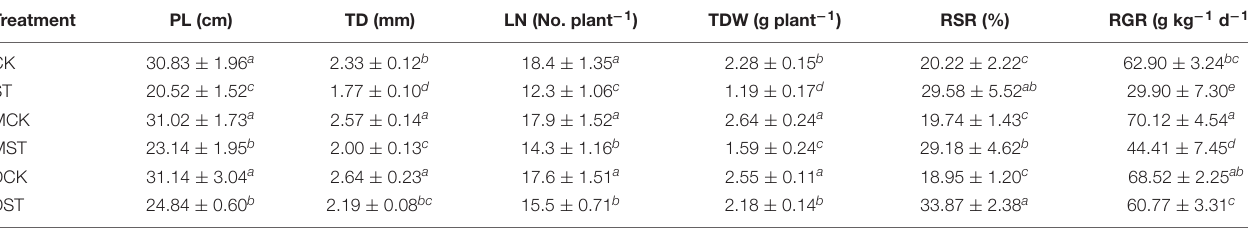
TABLE 2 | Plant length (PL), trunk diameter (TD), leaf number (LN), total dry weight (TDW), root-to-shoot ratio (RSR), and relative growth rate (RGR) for plants grown 20 days under different N levels and material treatments. Treatment